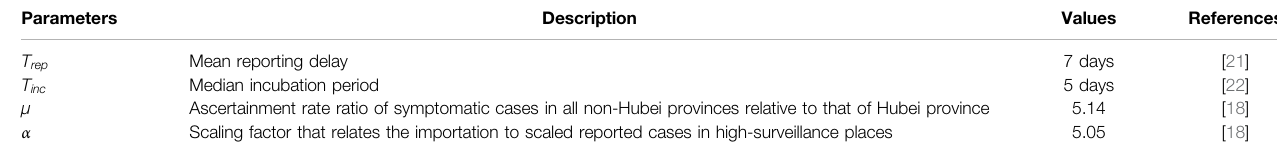
TABLE 1 | Model parameters in the modeling framework.